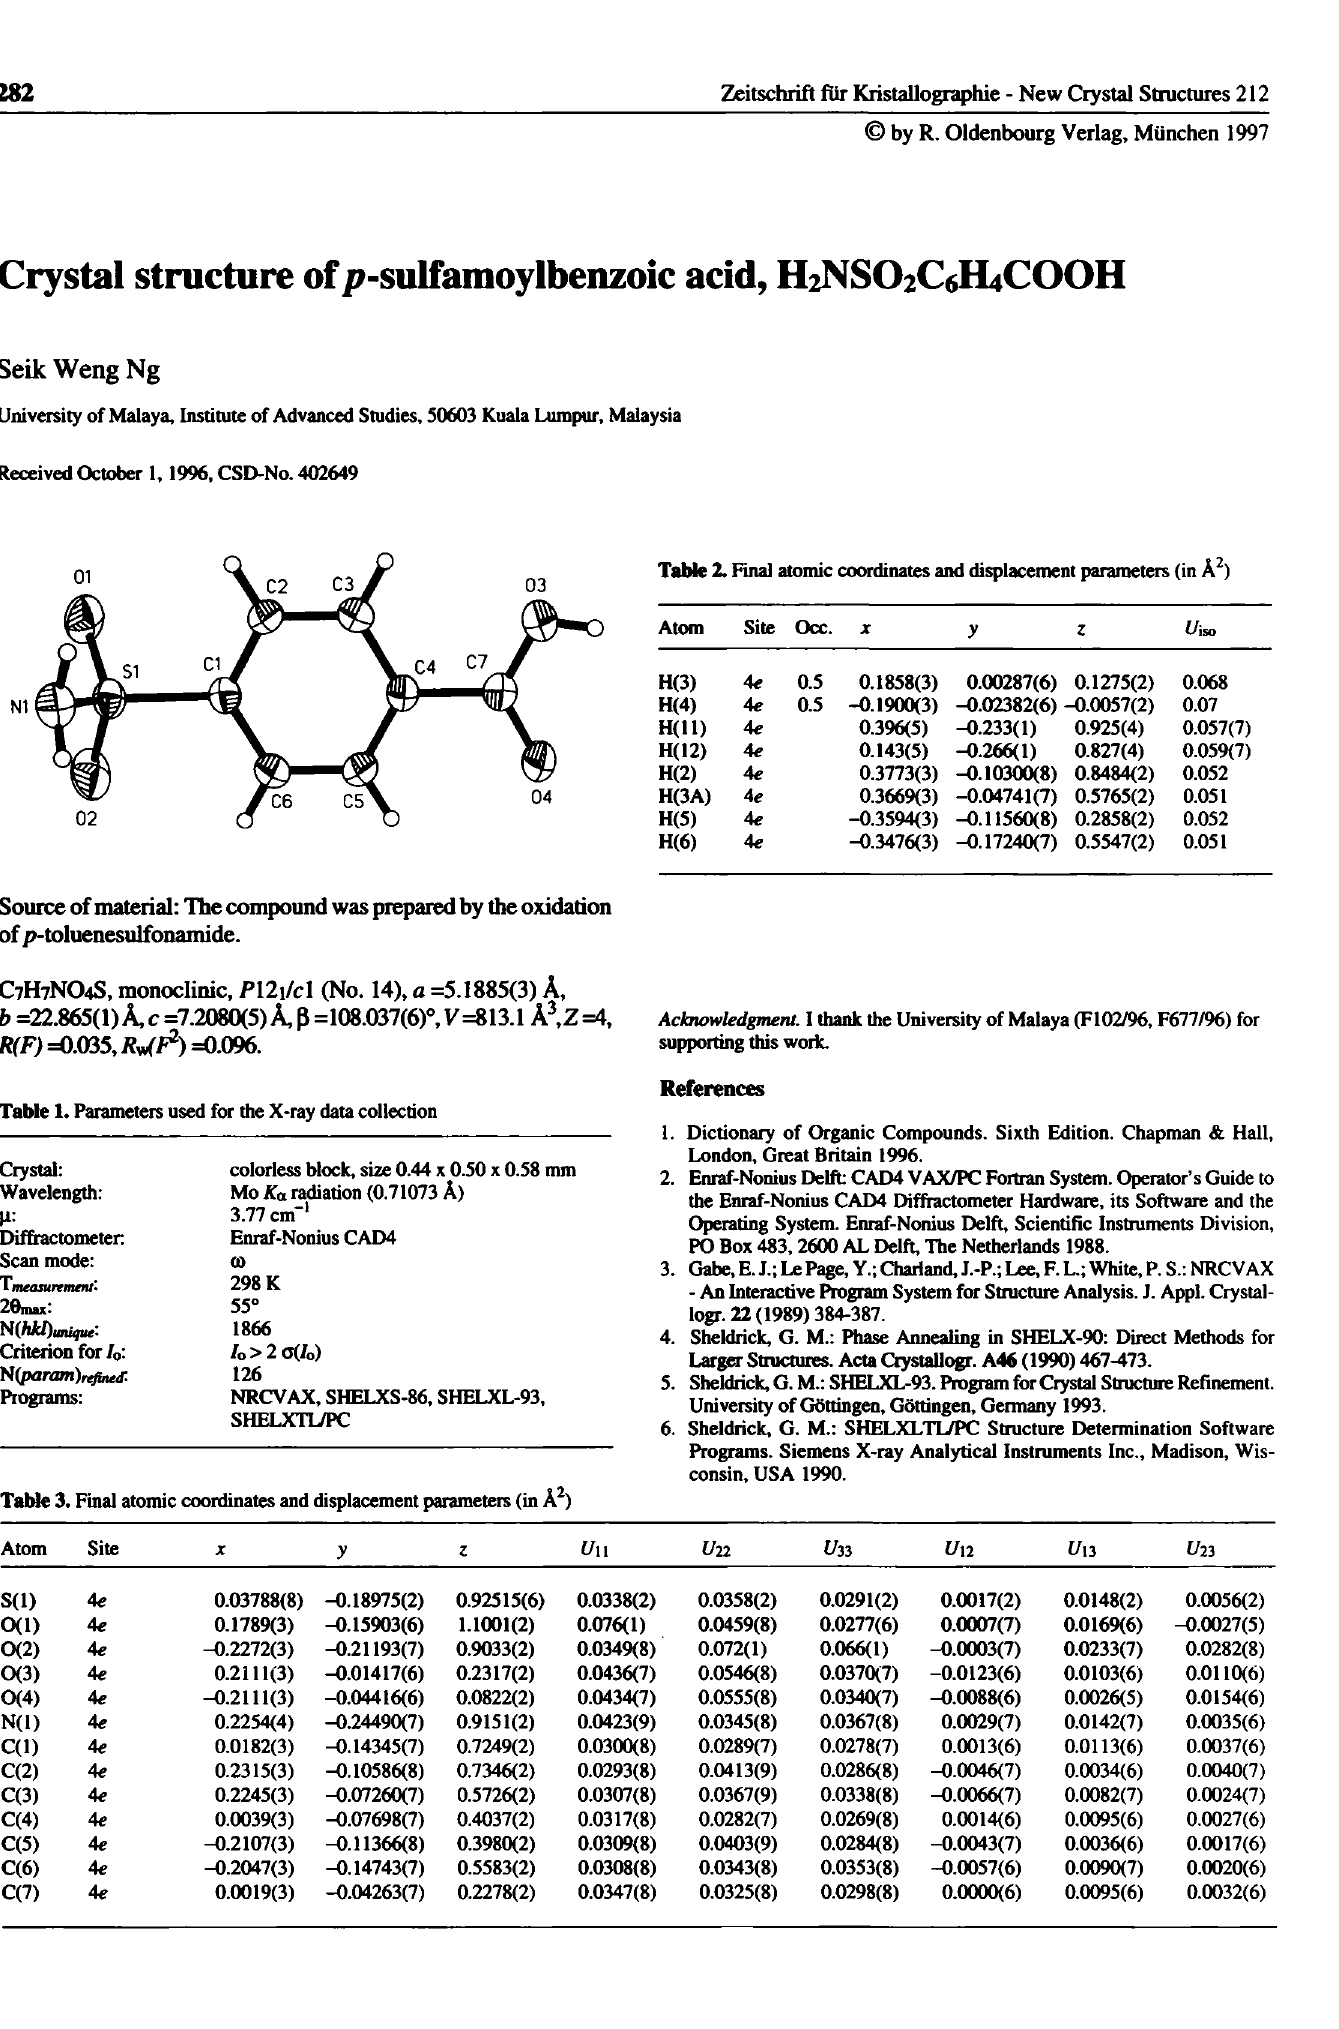
Table 2. Final atomic coordinates and displacement parameters (in Ä 2 )